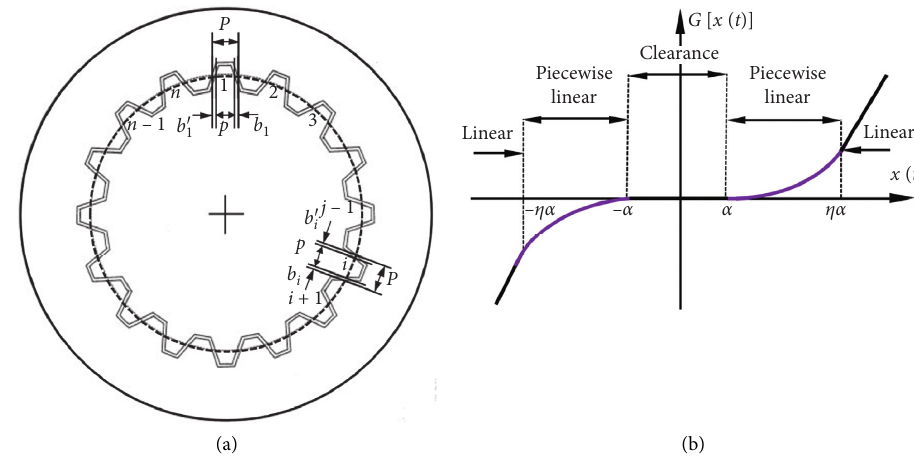
Figure 2: Schematic diagram of the spline joint model. (a) Spline connection model, (b) piecewise linear function of